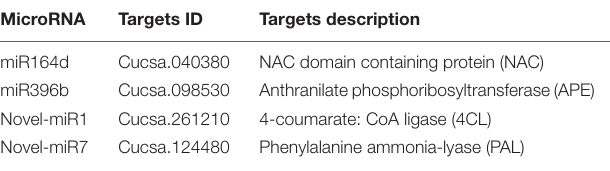
TABLE 1 | Candidate miRNAs and their